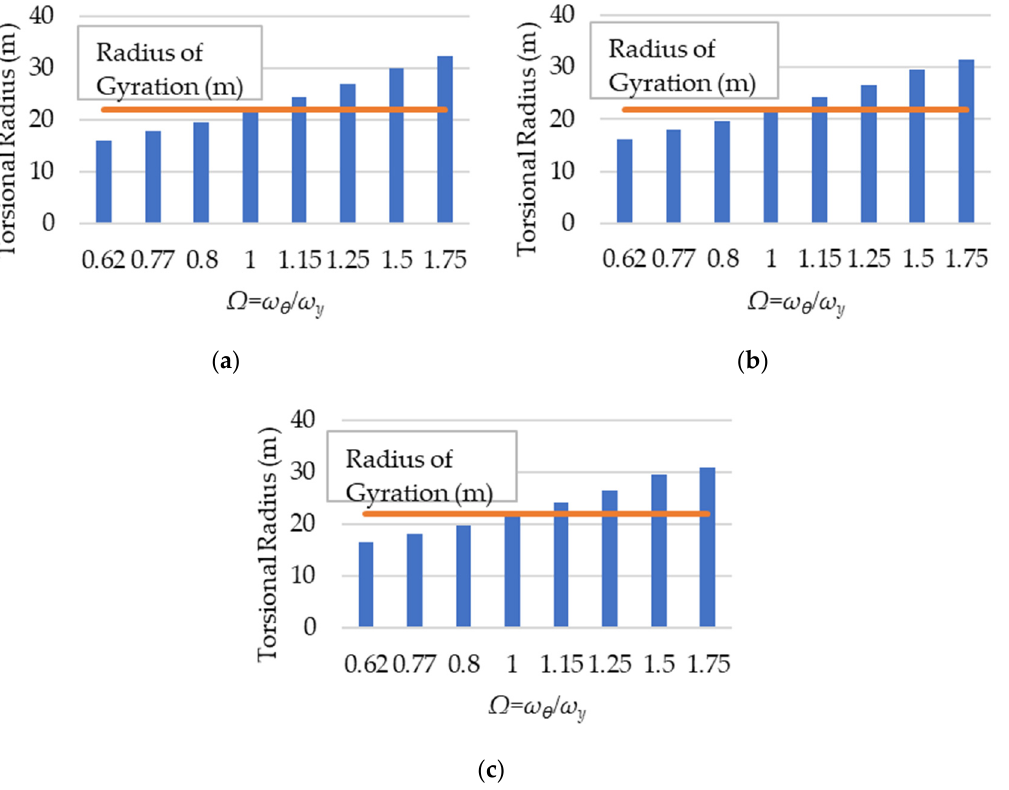
Figure 14. Torsional radius for buildings with ( r = 21.9 m & b/r = 1.10): ( a ) Building period T < 1 s; ( b ) Building period 1 < T < 2 s; ( c ) Building period T > 2 s.